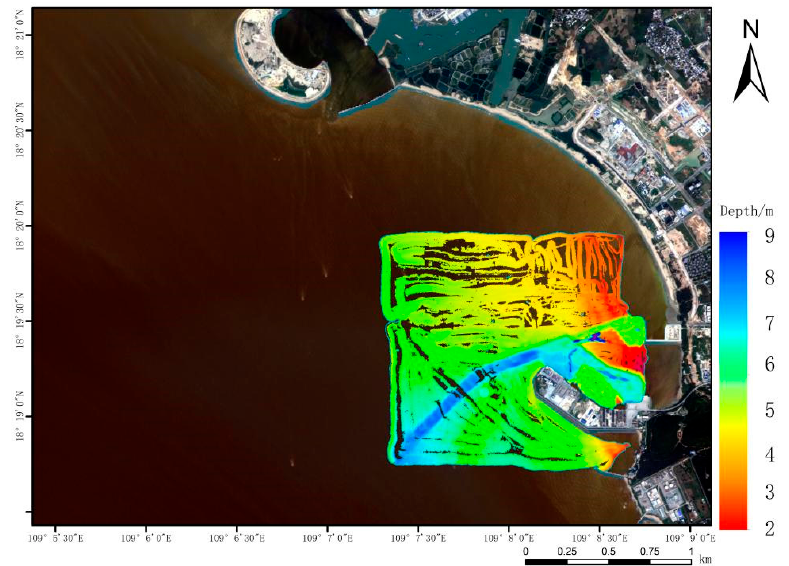
Figure 3 . Measured water depth map of Nanshan Port. Figure 3. Measured water depth map of Nanshan